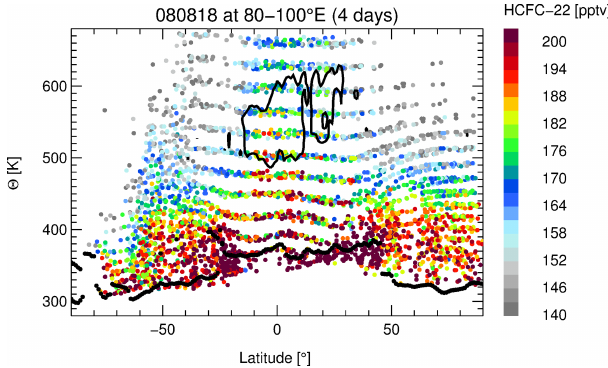
Figure 12. Latitude–theta cross sections of MIPAS HCFC-22 mea- surements crossing the eastern (80–100 ◦ E) mode of the anticyclone up to 680K potential temperature on 18 August 2008. The thermal tropopause is indicated by black dots. The contour line of 6% of the India/China tracer for the summer 2007 pulse is shown by thick black lines as shown in Fig. 9. To highlight the MIPAS HCFC-22 signal within the tropical pipe the plot range of the data is up to 200pptv. Note that the maximum values of MIPAS HCFC-22 in the troposphere are higher than